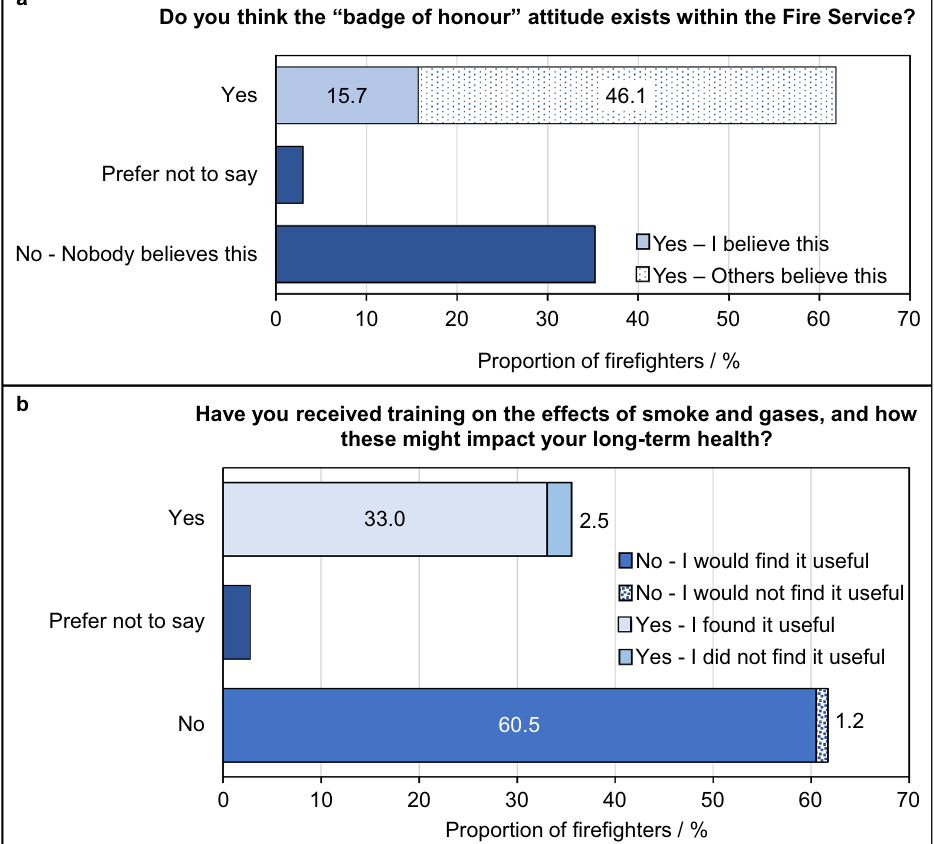
Figure 1. Training on fire contaminants and their associated health outcomes, and belief in the BoH attitude in the UK Fire and Rescue Service . Proportion of total surveyed firefighters who ( A ) hold/do not hold the BoH attitude, and ( B ) who have/have not received training on the health effects of fire contaminant